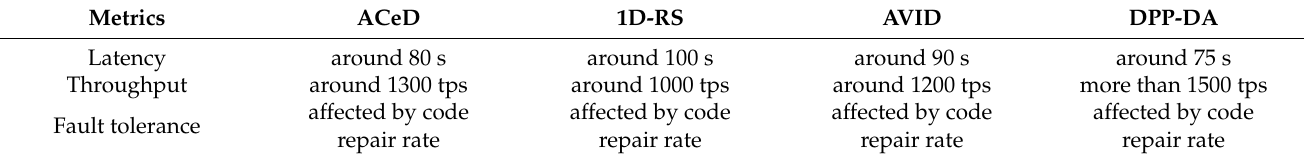
Table 2. Performance